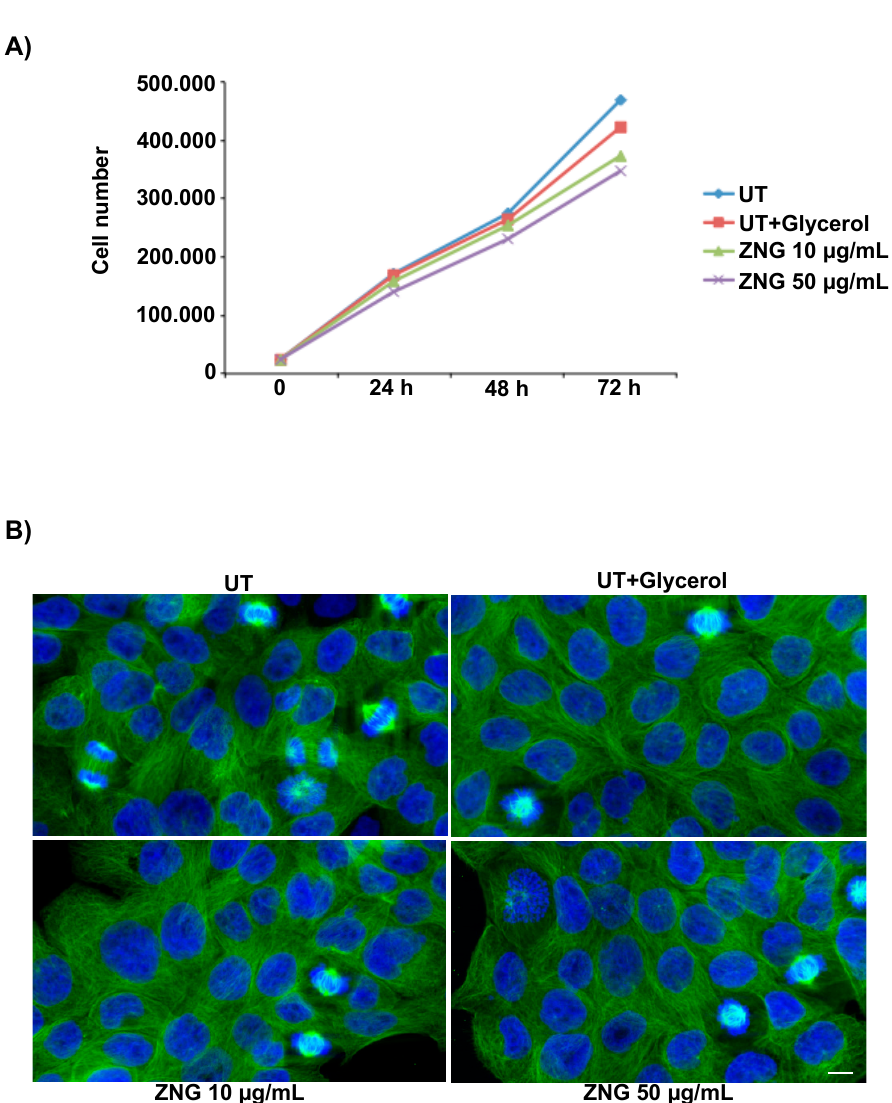
Figure 7. ( A ) Cell proliferation and ( B ) immunofluorescence analysis of FITC-tubulin staining of HaCaT cells after exposure to ZNGs. Scale bar represents 20 µm.